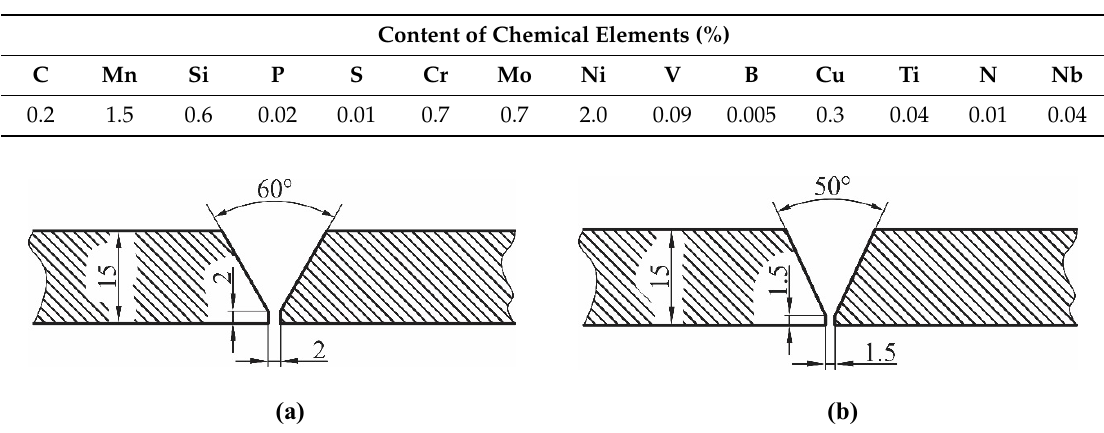
Figure 1. Shape and dimensions of the single V groove: ( a ) welding procedure MMA / MAG; ( b ) welding procedure MIG / МА G.